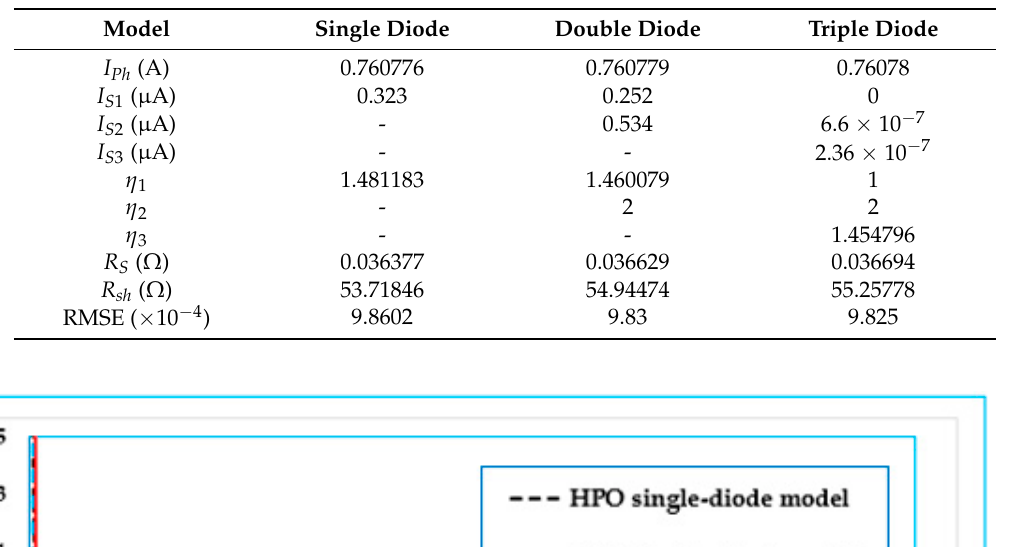
Table 9. Optimal values of extracted parameters using HPO technique for the three diode models with RTC France.